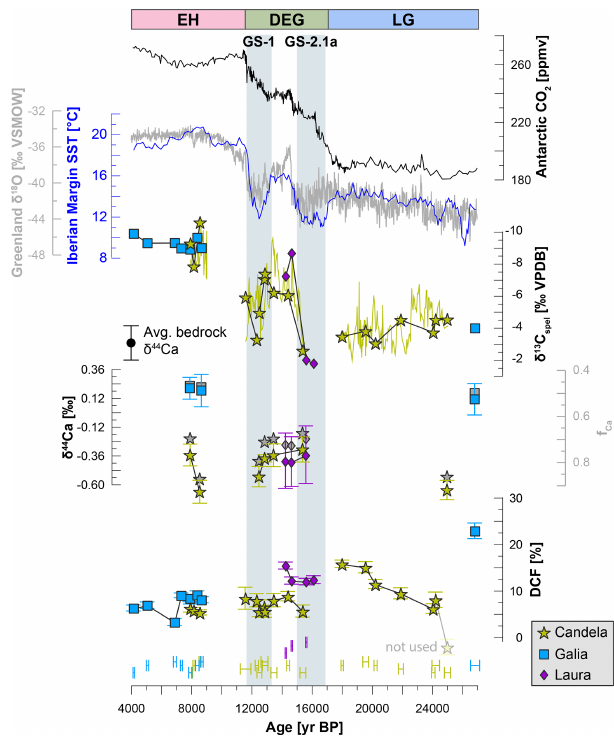
Figure 4. Proxy records from stalagmites Candela, Galia, and Laura over time (see Supplement Table S2), compared to regional temperature reconstructions (TEX 86 -derived sea surface tempera- tures from the Iberian Margin; Darfeuil et al., 2016), a Greenland ice core δ 18 O record (NGRIP on GICC05 timescale; Wolff et al., 2010), and global CO 2 (ice core composite from Antarctica; Bere- iter et al., 2015). The high-resolution δ 13 C spel record from Candela (thin green line) is shown for reference and was originally published in Moreno et al. (2010). The DCF values were calculated from 14 C measurements paired with U–Th ages. The time periods (LG, DEG, EH) at the top of the figure indicate the intervals used for the mod- elling to define temperature and atmospheric p CO 2 .